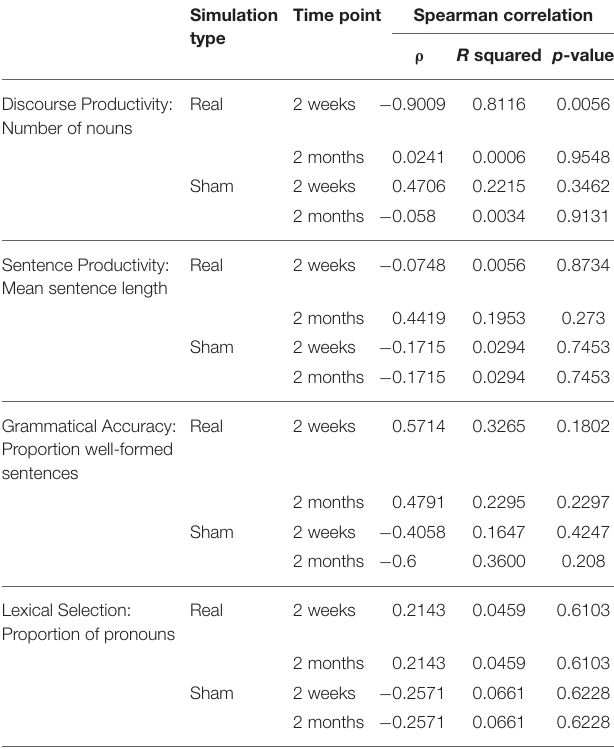
TABLE 2 | Proportion change in baseline of sentence productivity, grammatical accuracy, and lexical selection according to average baseline performance, represented by mean sentence length, proportion of well-formed sentences, and proportion proportion of pronouns at 2 weeks and 2 months following real and sham